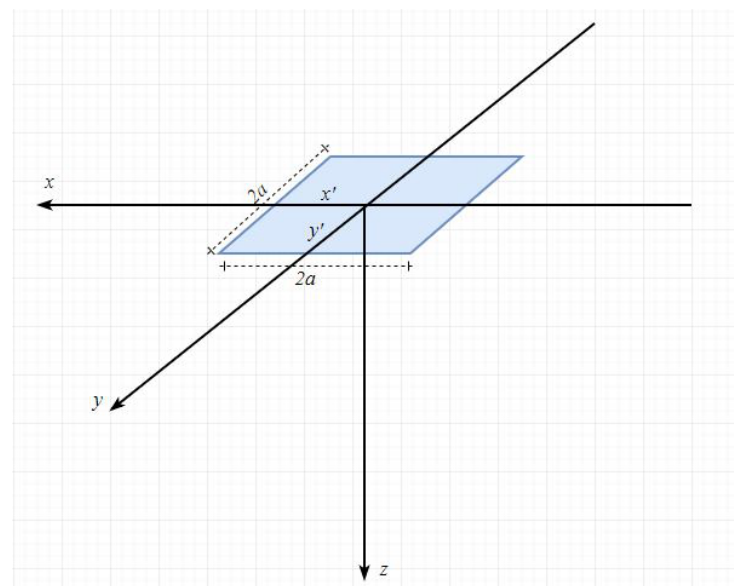
Figure 5. Geometry and coordinate system of an elastic